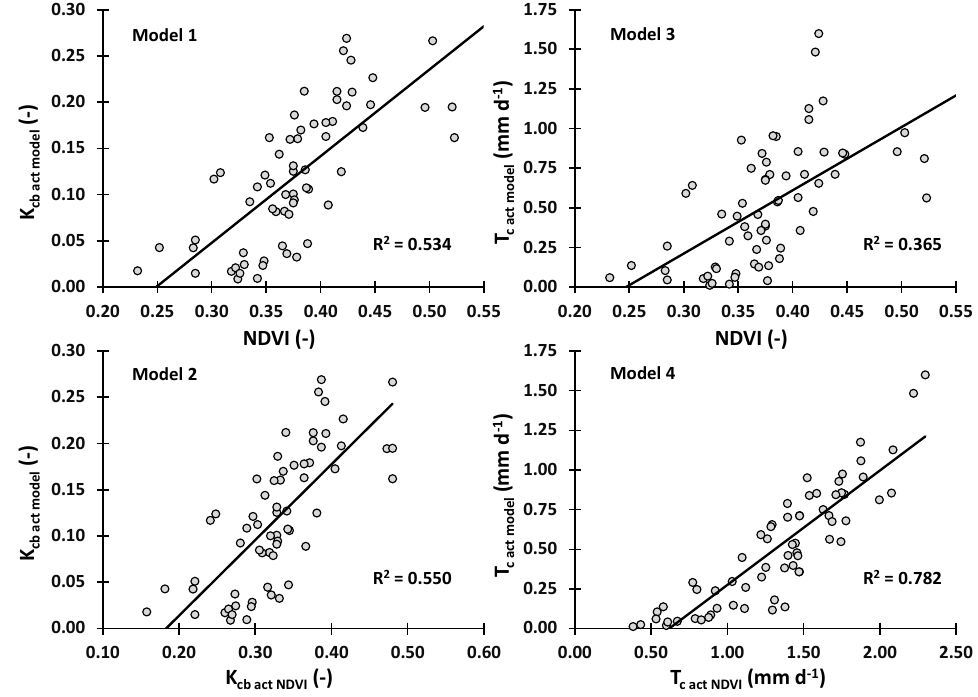
Figure 6. Scatterplots of the relationships between the actual basal crop coefficients (K cb act model ) and actual transpiration rates (T c act model ) computed using the MOHID-Land model (subscript model) and the corresponding indicators (K cb act NDVI and T c act NDVI ) derived from the normalized difference vegetation index (subscript NDVI).